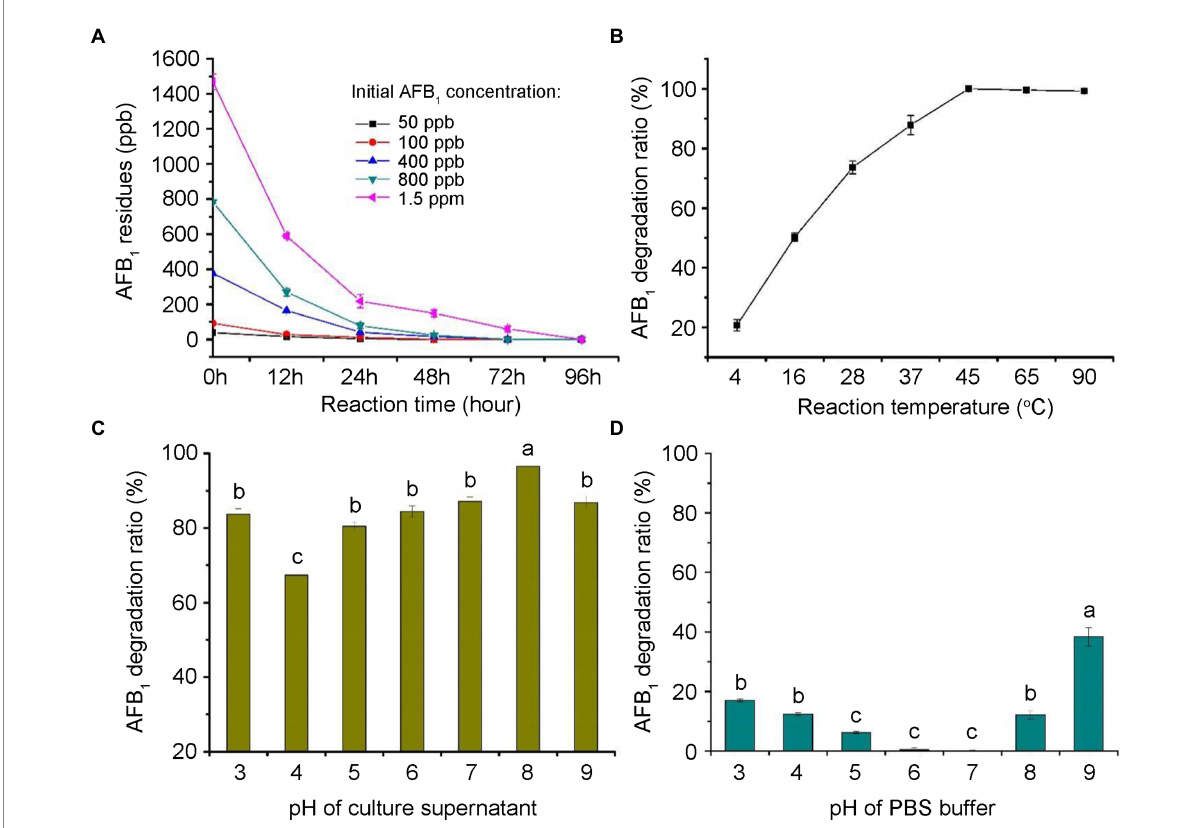
FIGURE 5 Degradation dynamics of aflatoxin B 1 (AFB 1 ) by the culture supernatant of T. reesei CGMCC3.5218. (A) Degradation of 50, 100, 400, 800 ng/kg, and 1.5 μ g/kg AFB 1 at various reaction time (0, 12, 24, 48, 72, and 96 h). (B) Degradation of 500 ng/kg AFB 1 at various temperatures of 4, 16, 28, 37, 45, 65, and 95 ° C. (C,D) Degradation of AFB 1 at a range of pH (3.0–9.0) in culture supernatant and PBS buffer. Bars with different letters are significantly different for p < 0.001 (Tukey–Kramer multiple comparison test). The values are the means of three replicates and their standard